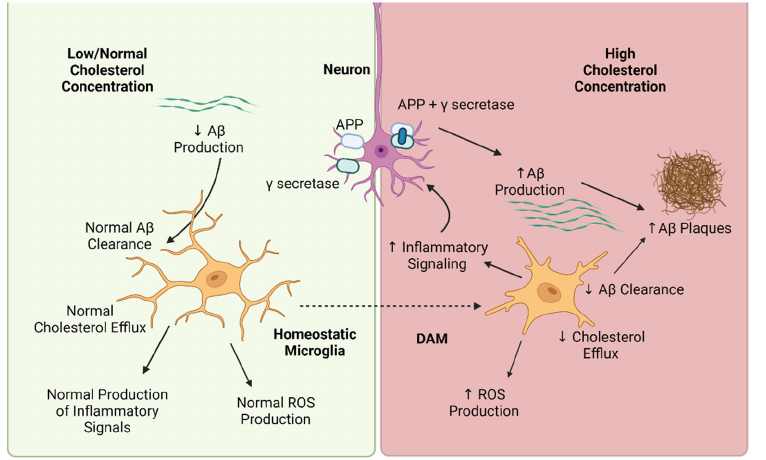
Figure 1. High cholesterol concentrations and disease-associated microglia (DAM). When cholesterol concentrations are low or normal the amount of amyloid- β (A β ) production is low, coupled with normal microglia A β clearance, and a homeostatic microglia phenotype with normal levels of cholesterol efflux, normal production of inflammatory signals and reactive oxygen species (ROS). Conversely, exposure to high cholesterol concentrations leads to increased production of A β by neurons due to colocalization of amyloid precursor protein (APP) and gamma secretase in the plasma membrane. Concurrently, high cholesterol concentrations lead to induction of the DAM phenotype, in which increased inflammatory signaling, increased production of ROS, and decreased cholesterol efflux hinder the ability of microglia to clear A β , further increasing the concentration of A β oligomers and driving plaque formation. Created with BioRender.com.